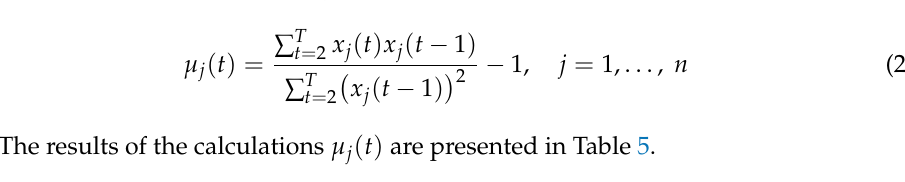
(cid:4666) 𝑡 (cid:4667) (author’s results) 𝑗